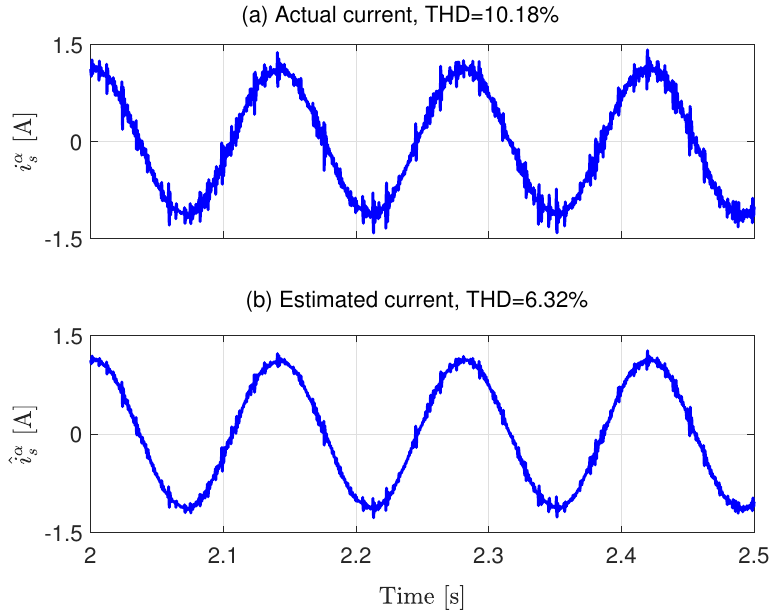
Figure 10. α -axis stator current of the PMSG: ( a ) measured, and ( b ) estimated.